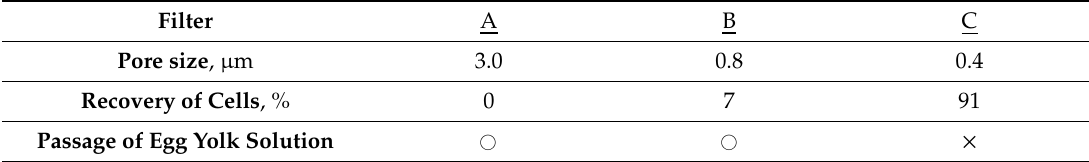
Table 1. Filtration of Salmonella enterica in egg yolk solution through polycarbonate membranes.